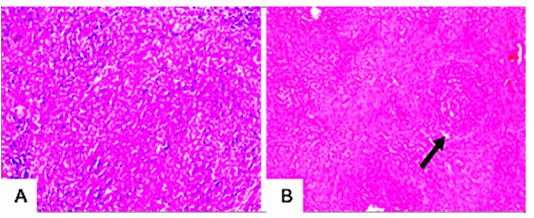
Figure 9. Histological examination of spleen tissues of albino rats; no histopathological alteration was observed in the histological structure of the white and red pulps, as well as sinusoids in untreated (control) rats ( A ); lymphoid depletion was detected in white pulps (black arrow) ( B